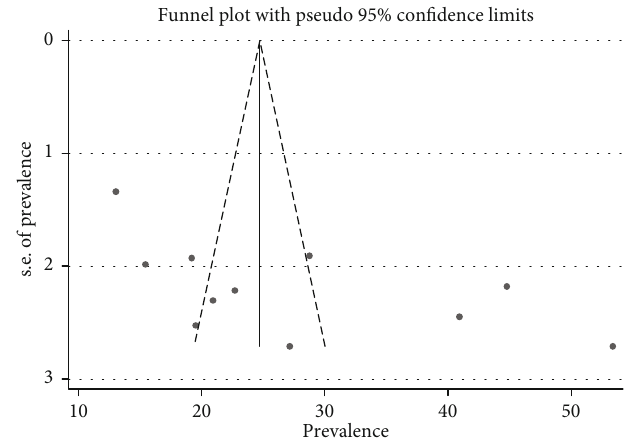
Figure 4: Funnel plot depicting publication bias of studies reporting the dual contraceptive use in